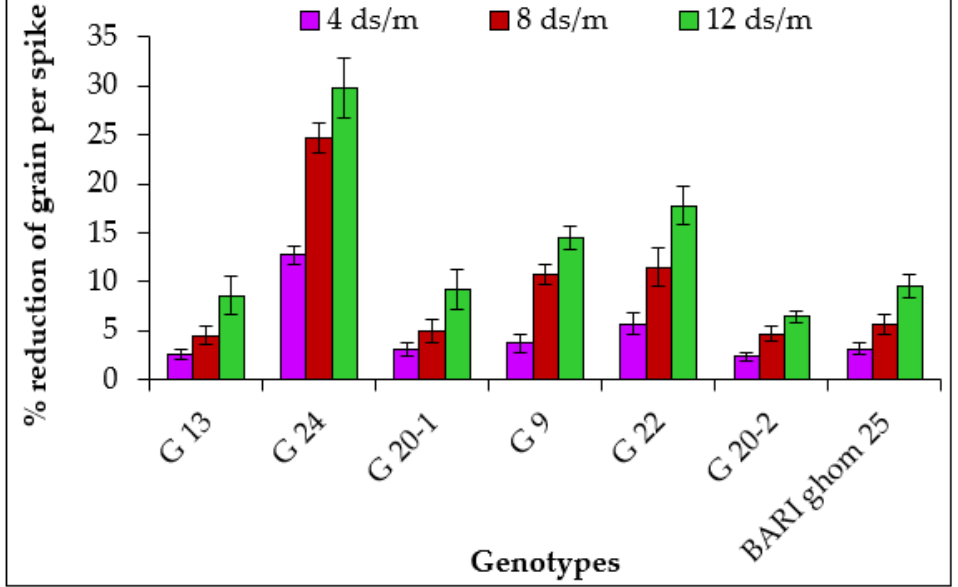
Figure 6. Reduction (%) of grain per spike of wheat genotypes under various salinity levels. The vertical bar indicates average of five independent replicates ( n = 5). Error bars represent standard error.